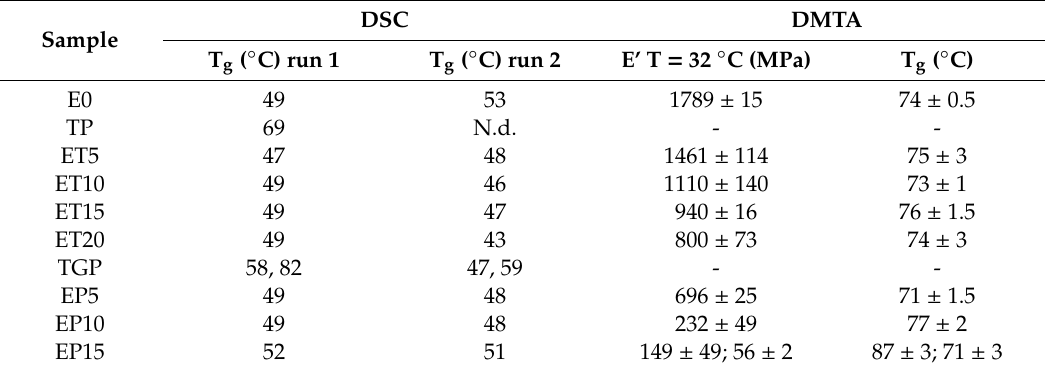
Table 3. T g and storage modulus (E’) obtained from DSC and DMTA experiments. N.d.: not